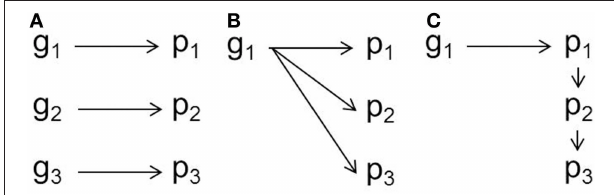
FIGURE 1 | Schematic of developmental genetic mechanisms underlying behavioral syndromes. (A) Linked genes (g) are associated with three correlated phenotypes (p). (B) One gene has pleiotropic effects on three phenotypes. (C) One gene affects one trait, which affects the development of other phenotypes, resulting in correlated traits. This latter mechanism, the focus of this research, would be considered a special case of “developmental”